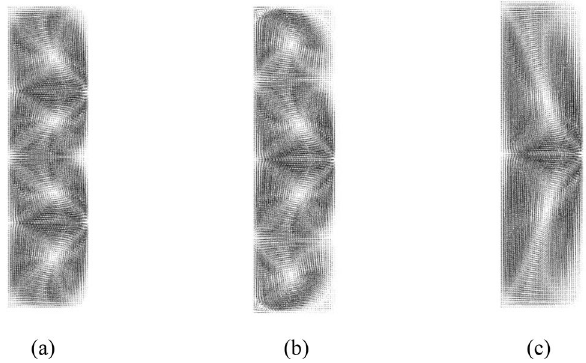
Fig. 5 Azimuthal-sectional view of the flow at Γ = 3.7, Re = 660: in each panel, the right side shows outer cylinder and the left side is inner cylinder. a is the normal 4-vortex flow (primary mode), b the anomalous 4-vortex flow (secondary mode), and c is the normal 2-vortex flow (secondary mode)